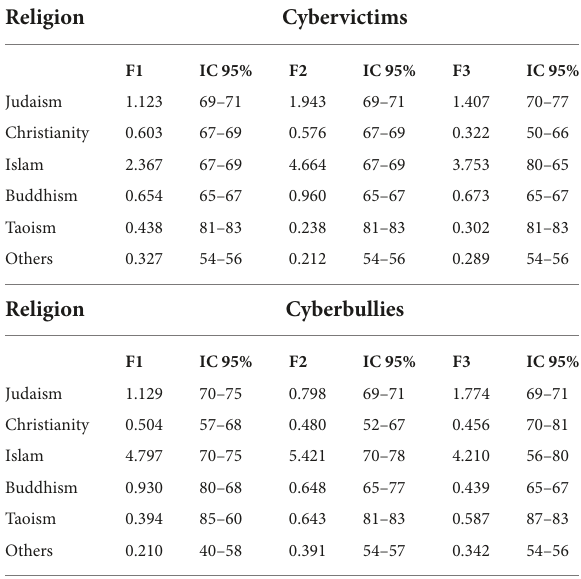
TABLE 8 Kruskal–Wallis H -test for cybervictims and cyberbullies according to